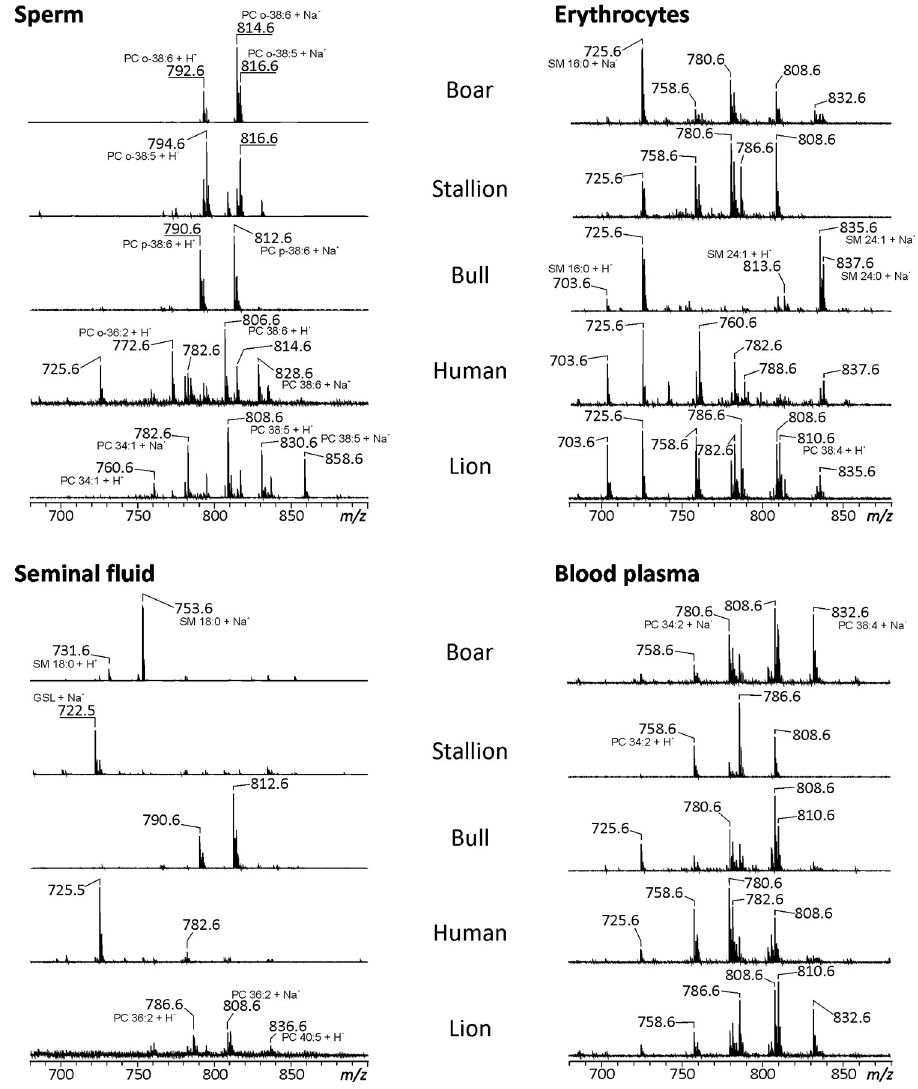
Fig 1. MALDI-TOF mass spectra of sperm, seminal fluid, erythrocytes and blood plasma samples. Extracted lipid- containing fractions from sperm, seminal fluid, erythrocytes and blood plasma samples of boar, stallion, bull, man and lion were mixed 1:1 with 0.5 M 2,5-dihydroxybenozoic acid (DHB) dissolved in methanol as matrix. A volume of about 0.75 μ L of this mixture was applied onto an MTP 384 target plate ground steel BC (Bruker Daltonik GmbH, Bremen, Germany) and mass spectra were subsequently recorded in the positive ion mode on a Bruker Autoflex Speed mass spectrometer (Bruker Daltonik GmbH). The mass-to-charge ( m/z ) ratios of the most prominent peaks are